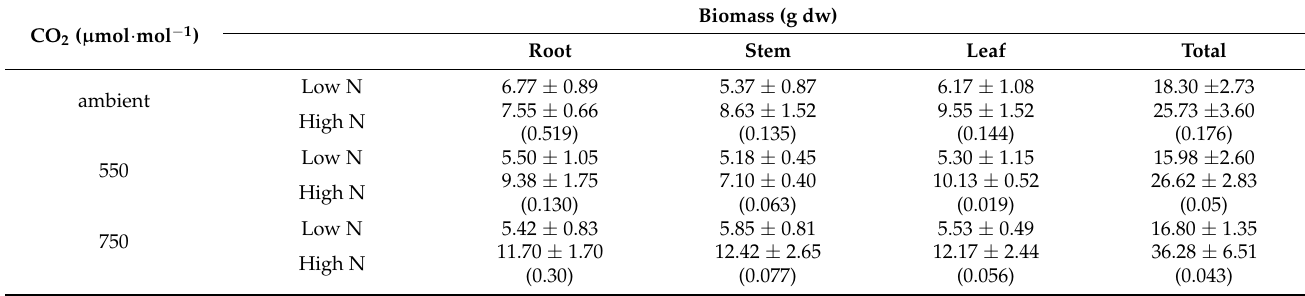
Table 1. Effects of elevated CO 2 and N fertilization on plant biomass. p -Values (in the brackets) indicate significant differences between mean values of low N and high N at the same CO 2 concentration. For the main effect of either CO2 or N fertilization, and the interaction between CO 2 and N fertilization, p -values indicate significant effects of that factor on these biomass variables; “NS” indicate no significant effects of a factor on biomass. dw, dry weight; Root, root biomass; Stem, stem biomass; Leaf, leaf biomass; Total, total biomass. CO 2 , different CO 2 concentration treatments; N, different N fertilization treatments; CO 2 × N, the interaction of CO 2 concentration and N